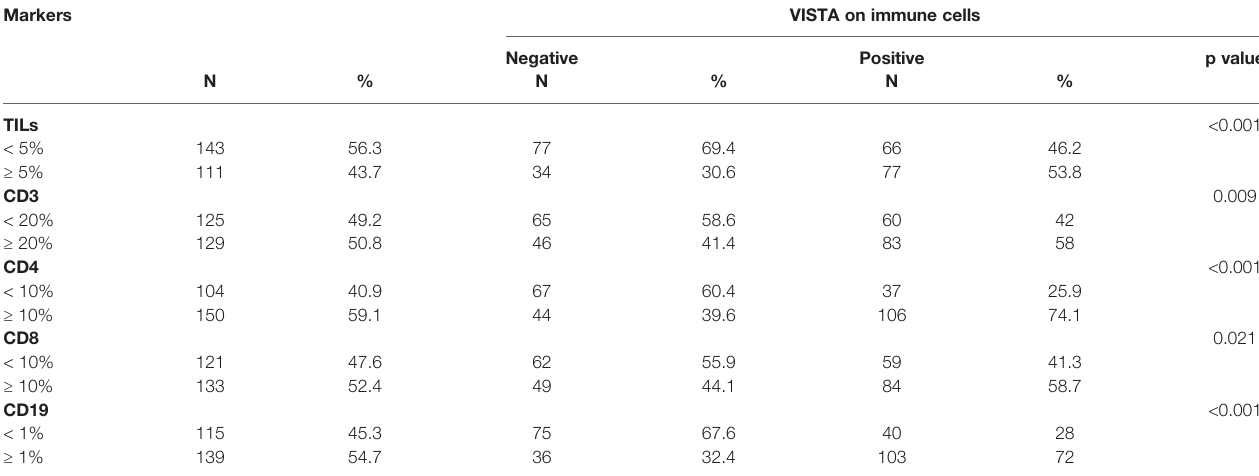
TABLE 2 | Correlation of VISTA on immune cells and other immune markers in TNBC.